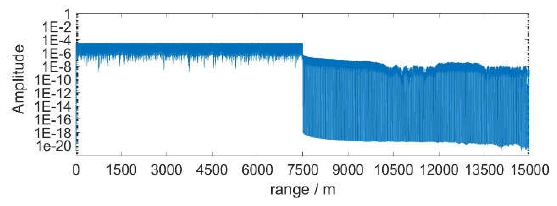
Figure 2 The amplitude of the ADC channel 1 versus the wind range